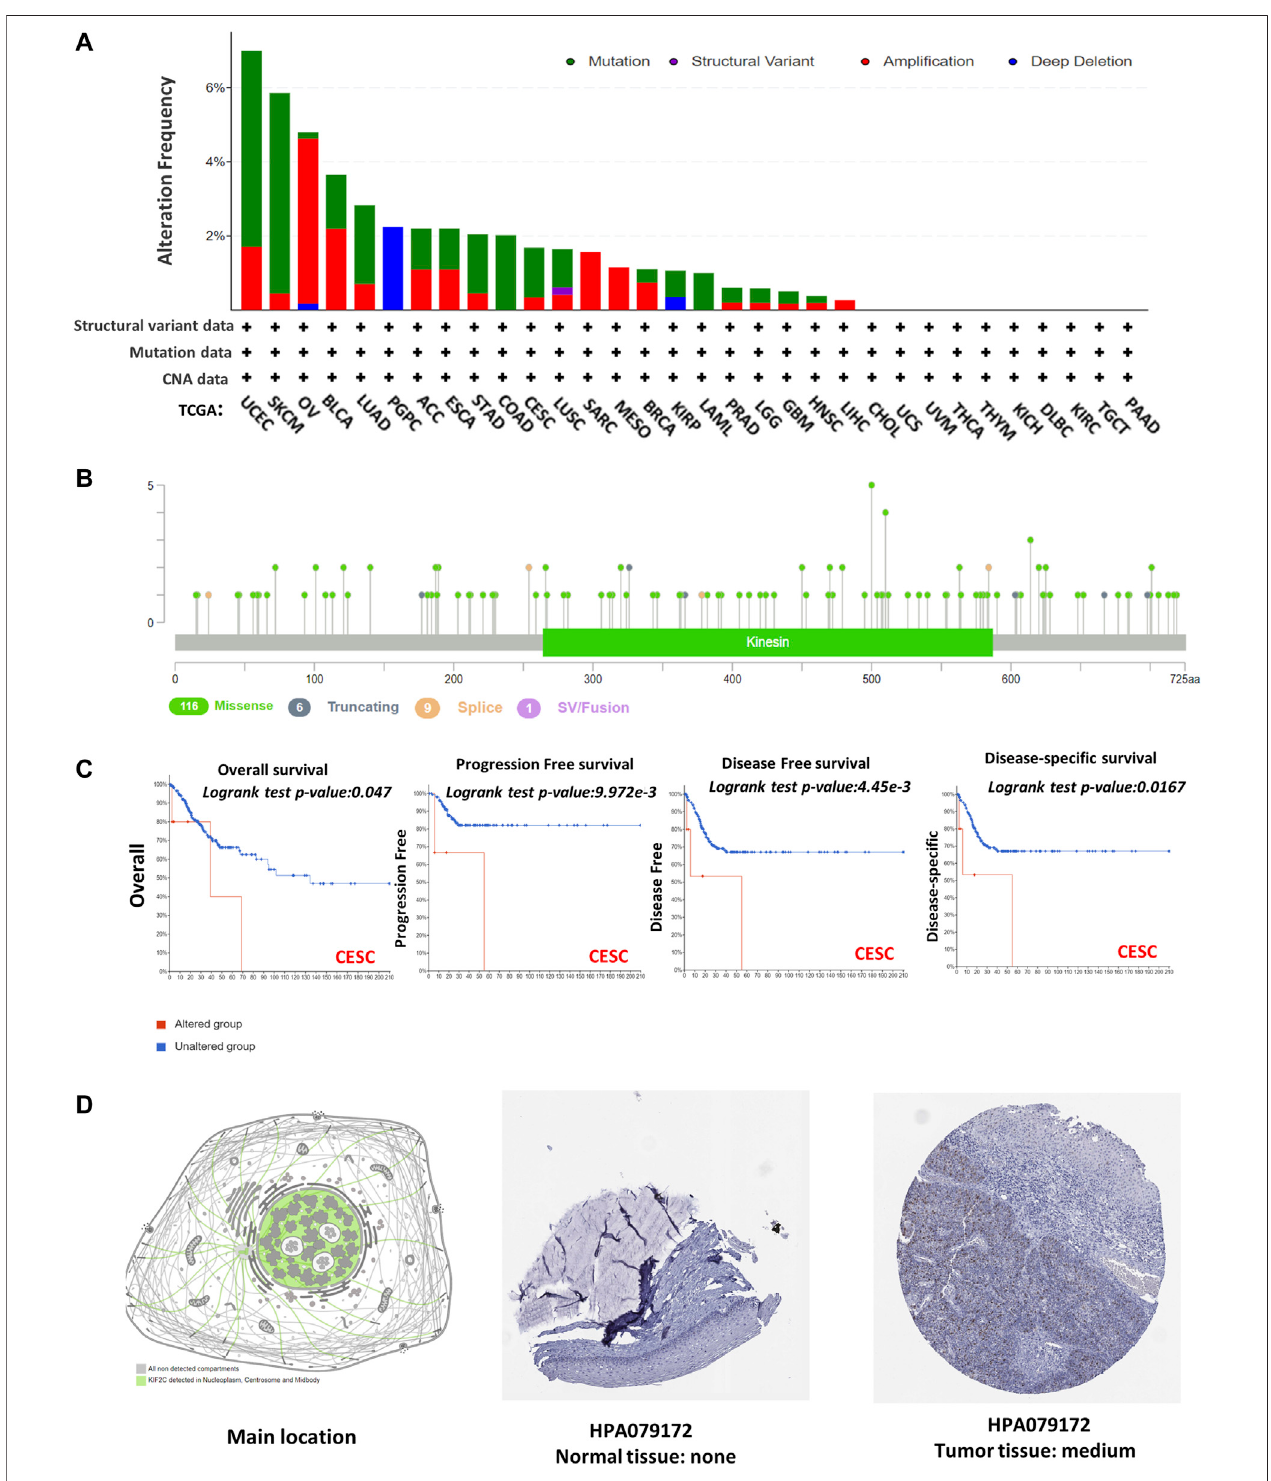
FIGURE4| Mutationfeatureandtissueproteinexpression ofKIF2CindifferenttumorsofTCGA.Mutationfeatures datawereobtainedusingcBioPortal.Alteration frequencies with (A) mutation type and (B) mutation site are shown. (C) Using cBioPortal tool, we analyzed potential correlation between mutation status and overall, disease-speci fi c, disease-free, and progression-free survivals of CESC. Nuclear localization of KIF2C and immunohistochemical results in CESC are shown in (D).